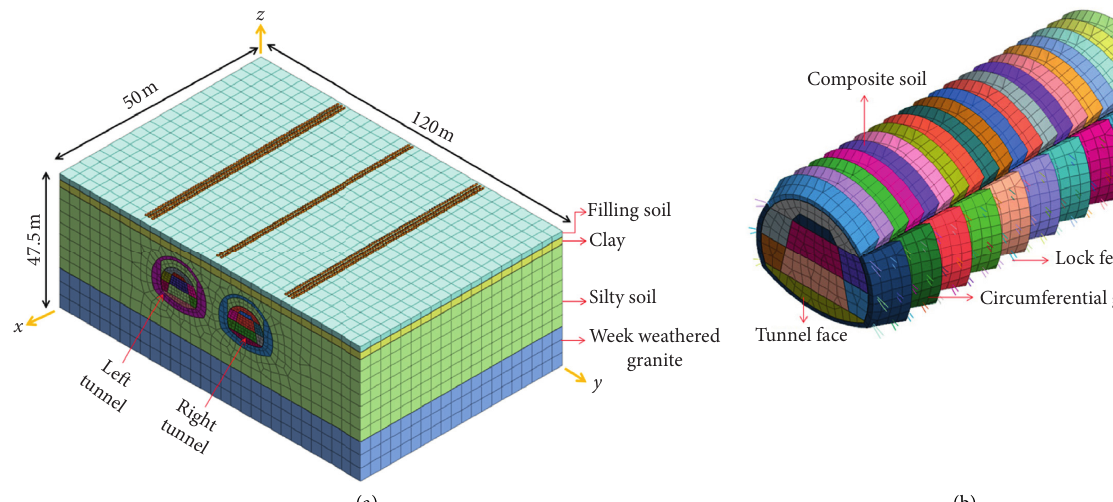
Figure 8: Mesh model. (a) Whole numerical model, (b) Support